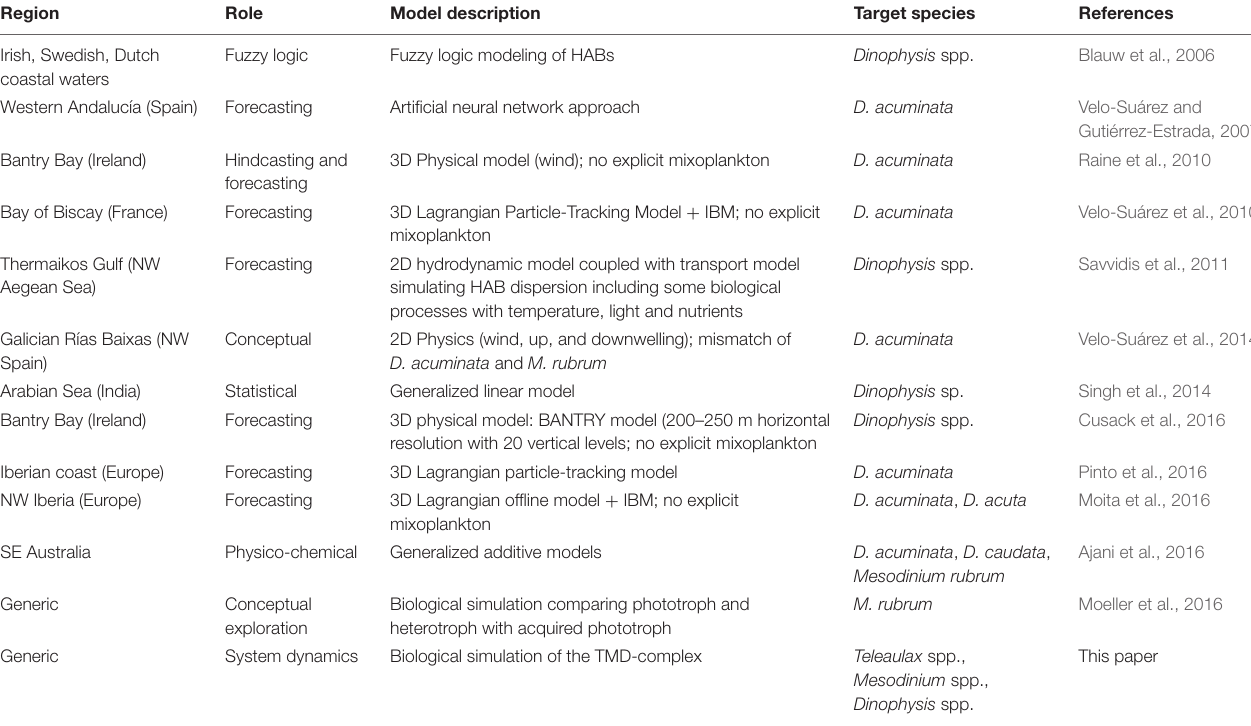
FIGURE 1 | Global distribution of Teleaulax , Mesodinium, and Dinophysis species. Records of Dinophysis ovum are merged with Dinophysis acuminata as they are likely the same species (Park et al., 2019). The data were obtained from the Ocean Biogeographic Information System (OBIS) database, and the Longhurst provinces were added as described in Leles et al. (2017). Each dot represents a recorded observation. TABLE 1 | Examples of modeling studies reporting facets of growth dynamics and ecology of Dinophysis and Mesodinium .